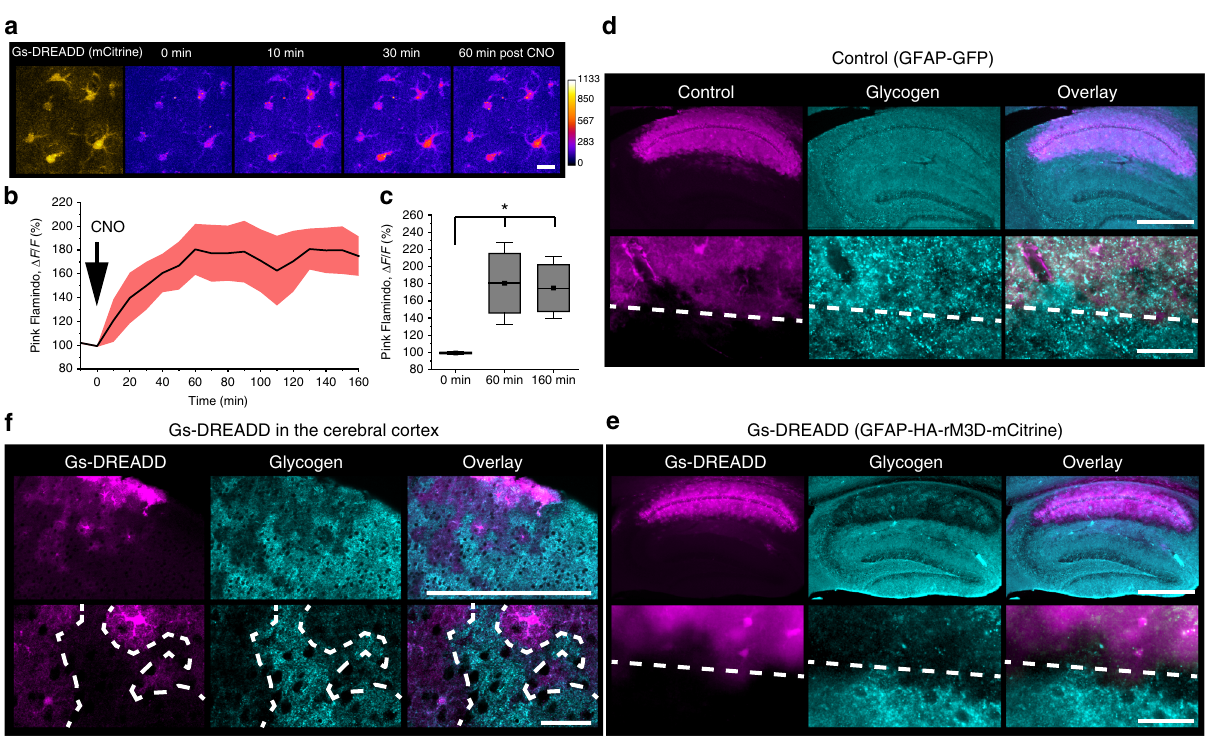
Fig. 8 Chemogenetic elevation of astrocytic cAMP induces glycogen breakdown. a Representative images of Gs-DREADD with mCitrine (yellow) and